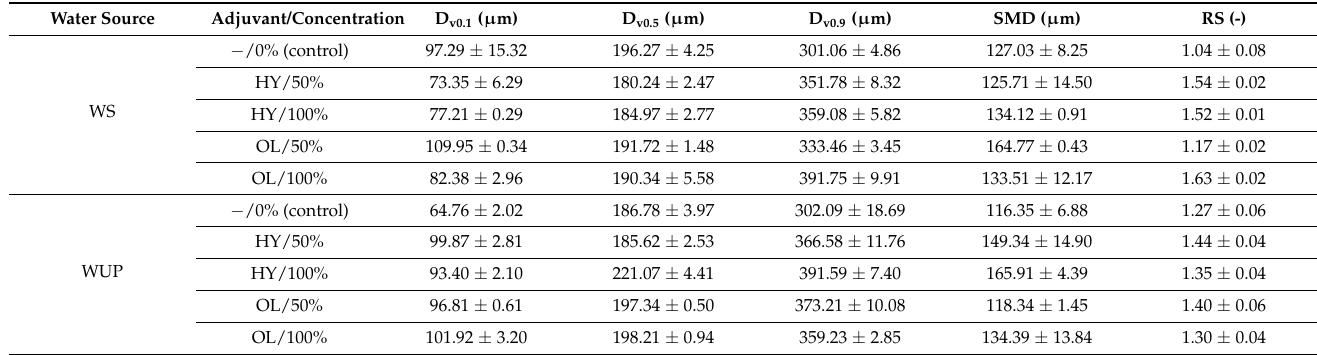
Table 5. Effect of water type, adjuvant type, and concentration on droplet size characteristics (mean ± standard